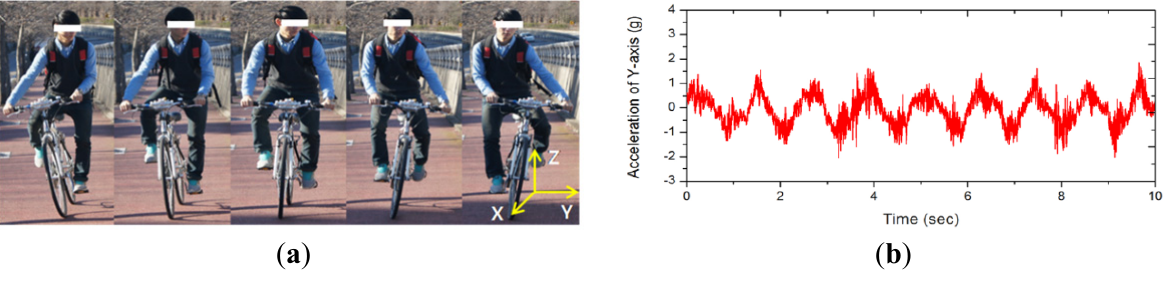
Figure 2. The weaving motion and its acceleration in experimental ride. ( a ) weaving motion accompanying uphill ride; ( b ) Y-axis